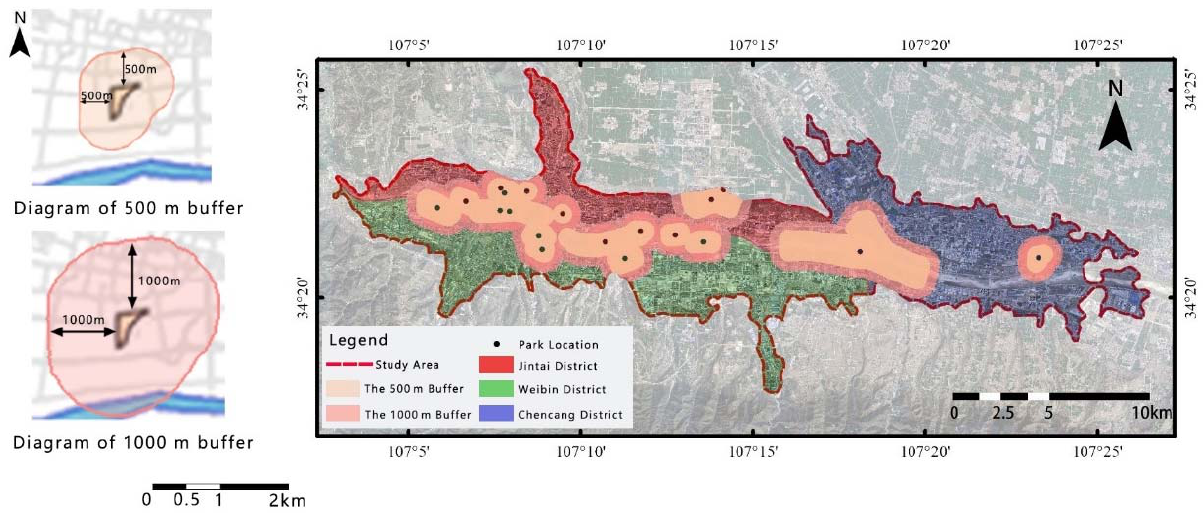
Figure 3. Park accessibility at 500 and 1000 m in the study area.